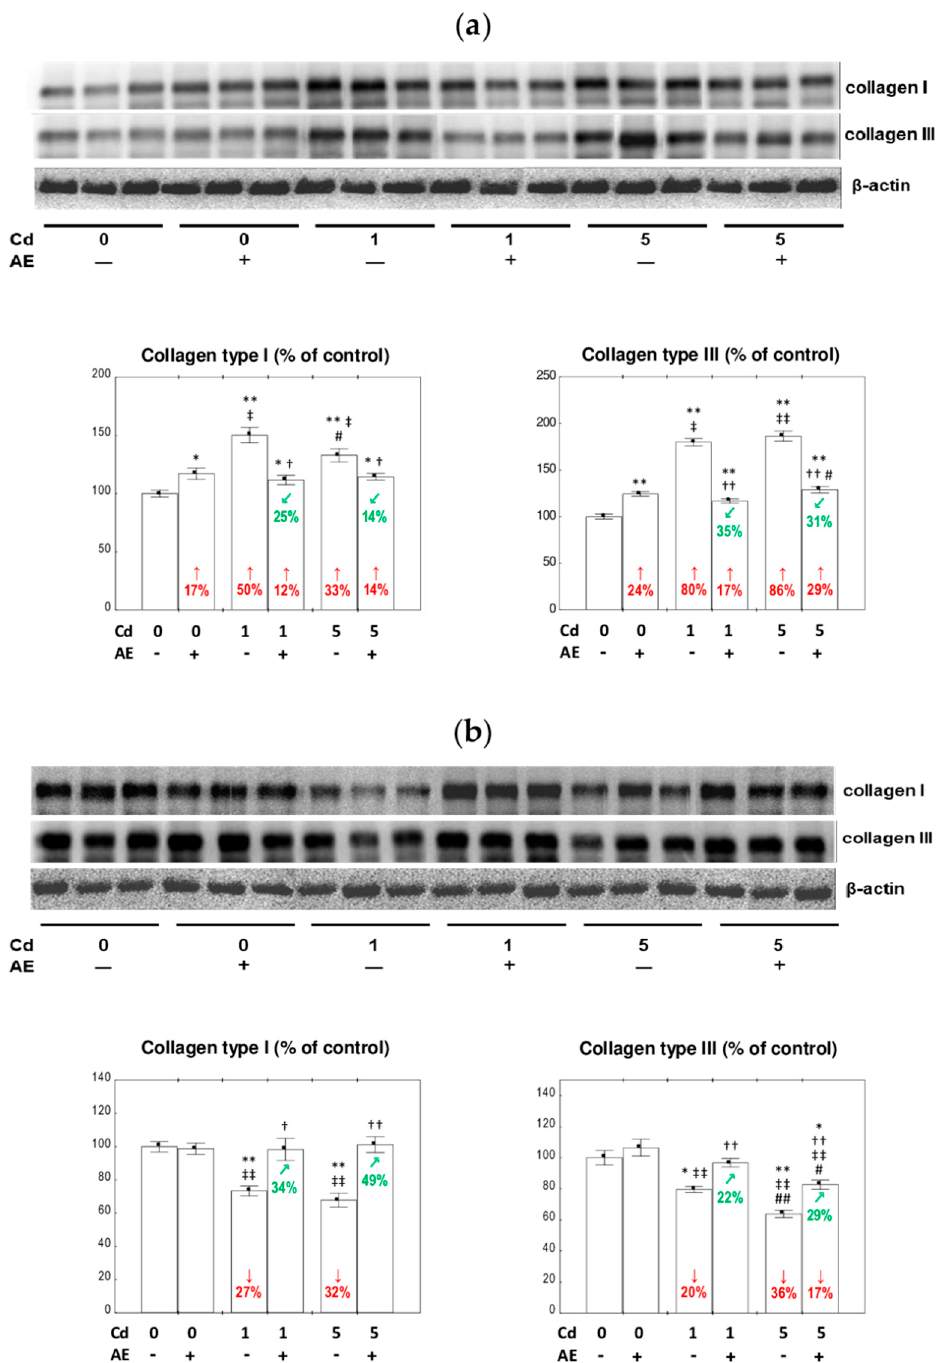
Figure 4. The impact of Aronia melanocarpa L. berry extract (AE) on the expression of collagen type I and collagen type III at the protein level in the livers of rats exposed to cadmium (Cd) for 17 ( a ) and 24 ( b ) months. The animals were treated with Cd at the concentrations of 0, 1, and 5 mg Cd / kg in their diets and / or 0.1% aqueous AE ( + ) or not ( − ). Representative gels of Western blotting are presented. Data are shown as mean ± SE for eight rats, except for seven animals in the AE, Cd 1 , and Cd 5 groups after 24 months. Statistically significant di ff erences (Kruskal–Wallis post hoc test): * p < 0.05 and ** p < 0.01 vs. control group; † p < 0.05 and †† p < 0.01 vs. appropriate Cd group; ‡ p < 0.05 and ‡‡ p < 0.01 vs. AE group; # p < 0.05 and ## p < 0.01 vs. appropriate group maintained on the 1 mg Cd / kg diet (Cd 1 group or Cd 1 + AE group). Numerical values in bars express the percentage changes or factors of changes in comparison to the control group ( ↑ , increase; ↓ , decrease) or the appropriate group exposed to Cd alone ( ↗ , increase; ↙ , decrease)